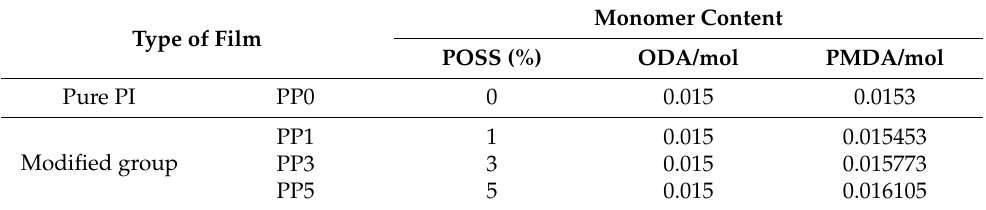
Table 1. Modification